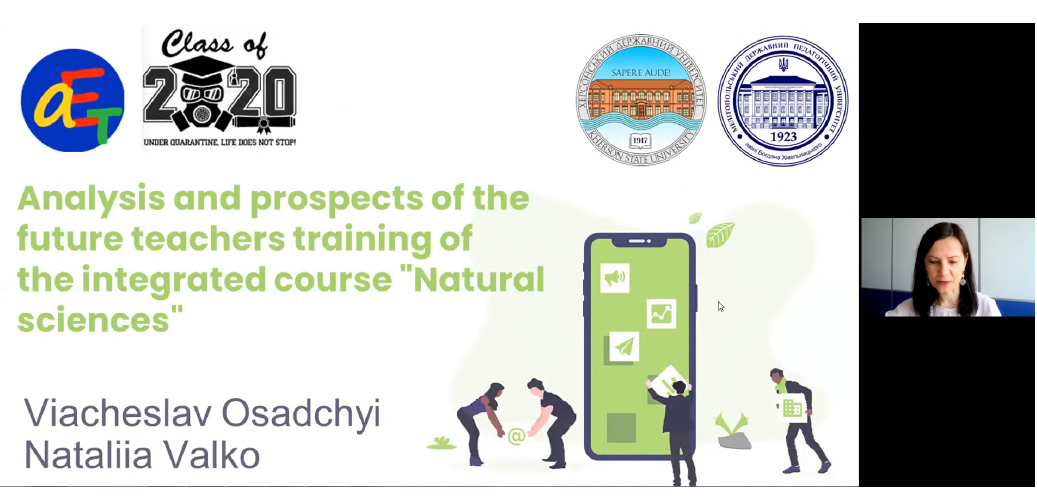
Figure 79: Presentation of paper